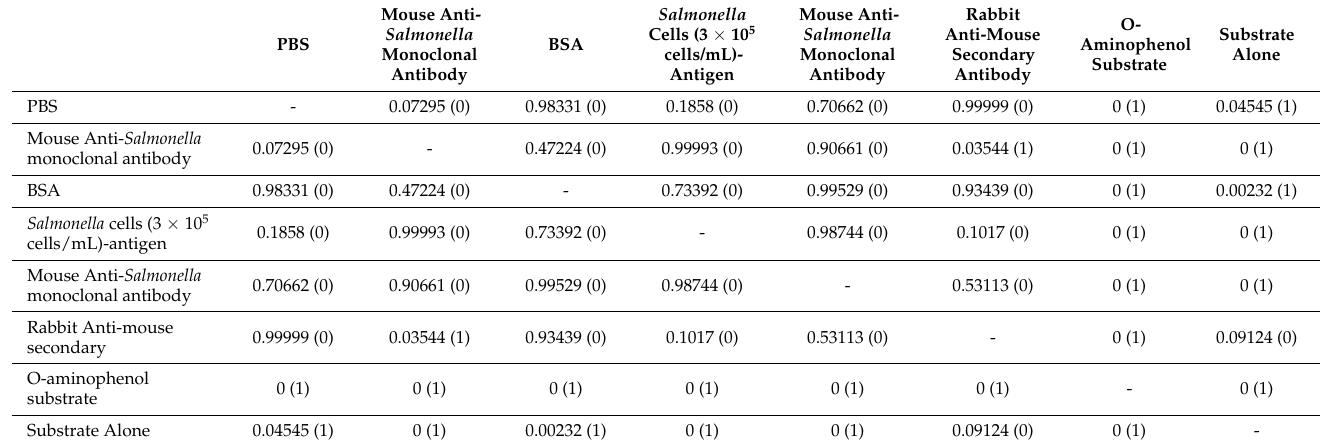
Table 2. Comparison of response signal output current recorded during the fabrication of sensor.